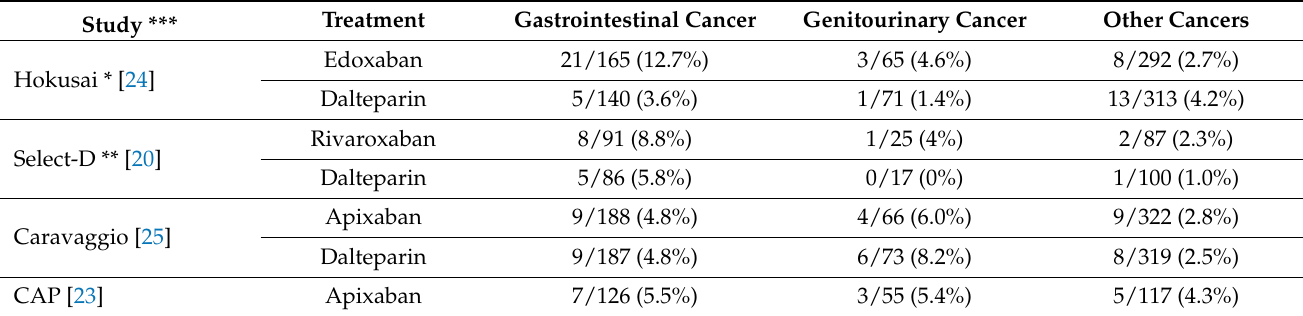
Table 5. Numbers of major bleedings during 6 months treatment in patients with gastrointestinal and genitourinary cancers.